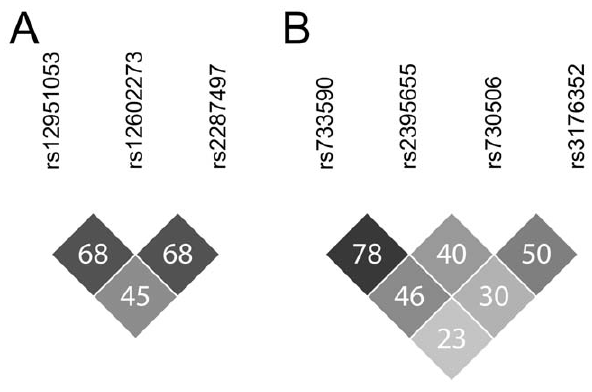
Figure 1. Linkage disequilibrium plot. Showing pairwise r 2 for SNPs in TP53 (A) and CDKN1A (B).